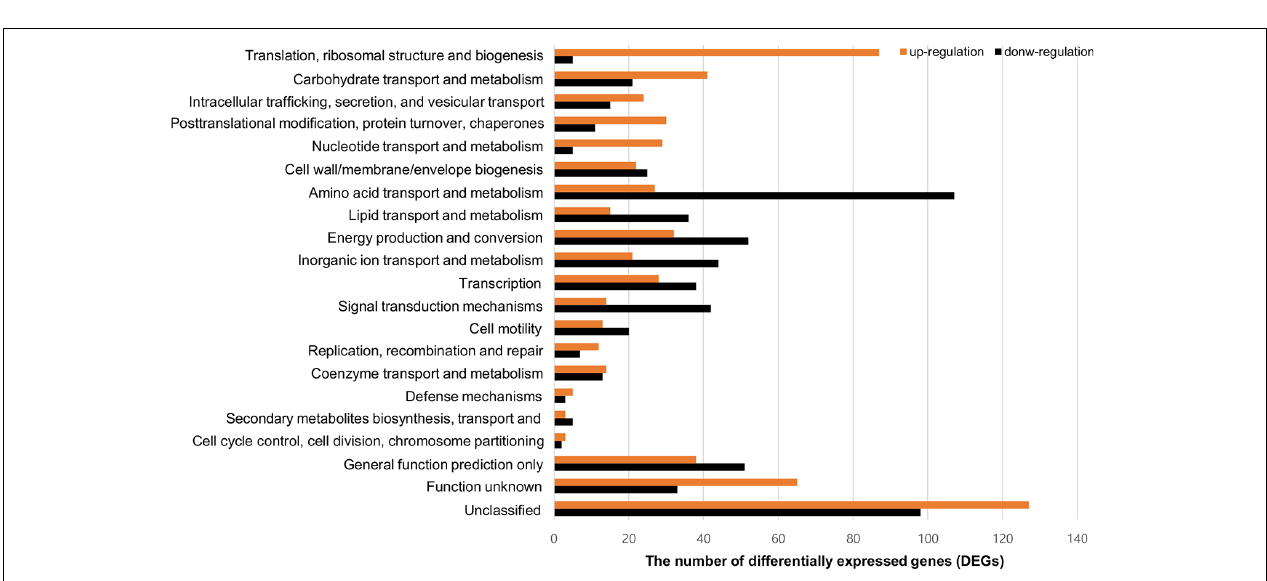
FIGURE 3 | A pangenome analysis between three V. parahaemolyticus strains. The central circle belongs to the main bacterial strain, and the outer circles belong to other strains. The innermost circle shows the pangenome (green color), and the outer circles indicate the V. parahaemolyticus strains FORC_022 (orange), CDC_K4557 (red), and RIMD2210633 (dark brown).